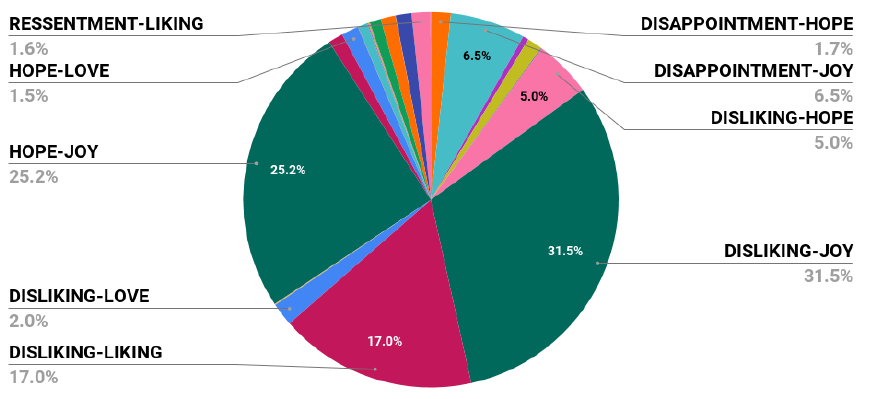
Figure 22. User_emotion/robot_emotion